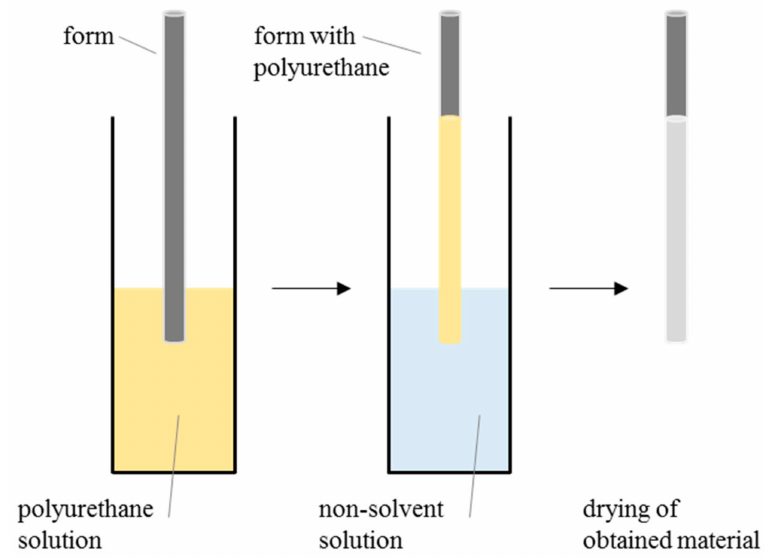
Figure 13. Scheme presenting the method for prosthesis